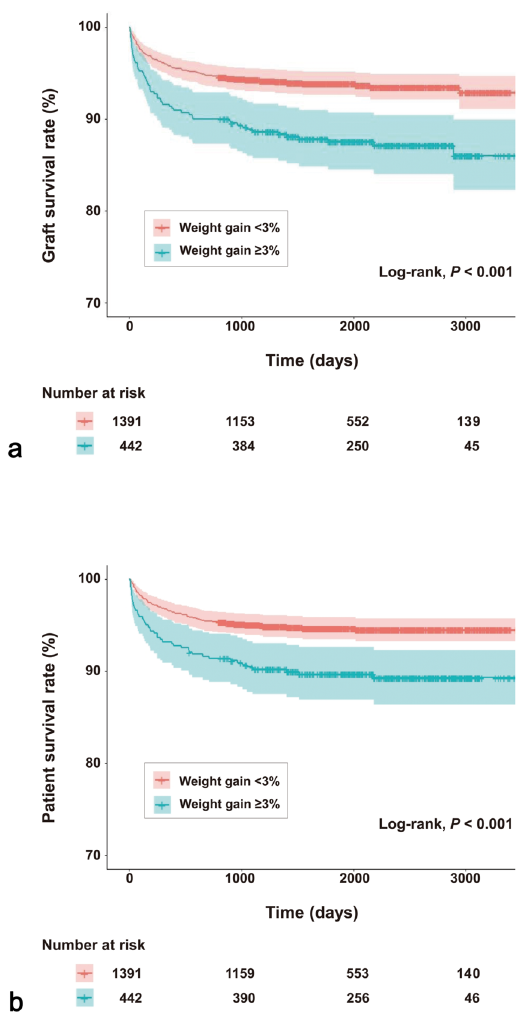
Figure 2. ( a ) Graft and ( b ) patient survival rates stratified by postoperative weight gain ( < 3% or ≥ 3%) in living donor liver transplantation recipients. Survival curves are provided with 95% confidence intervals.